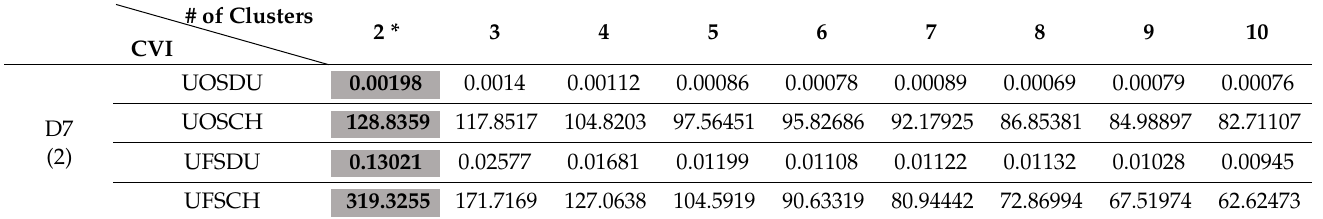
Table 8. Performance results for D7.